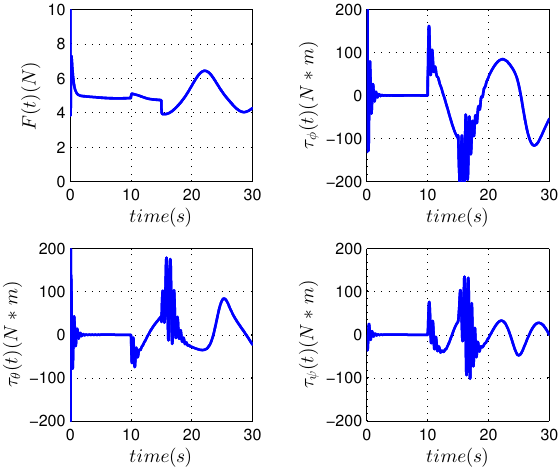
Figure 5. UAV’s Attitude Tracking Performance.